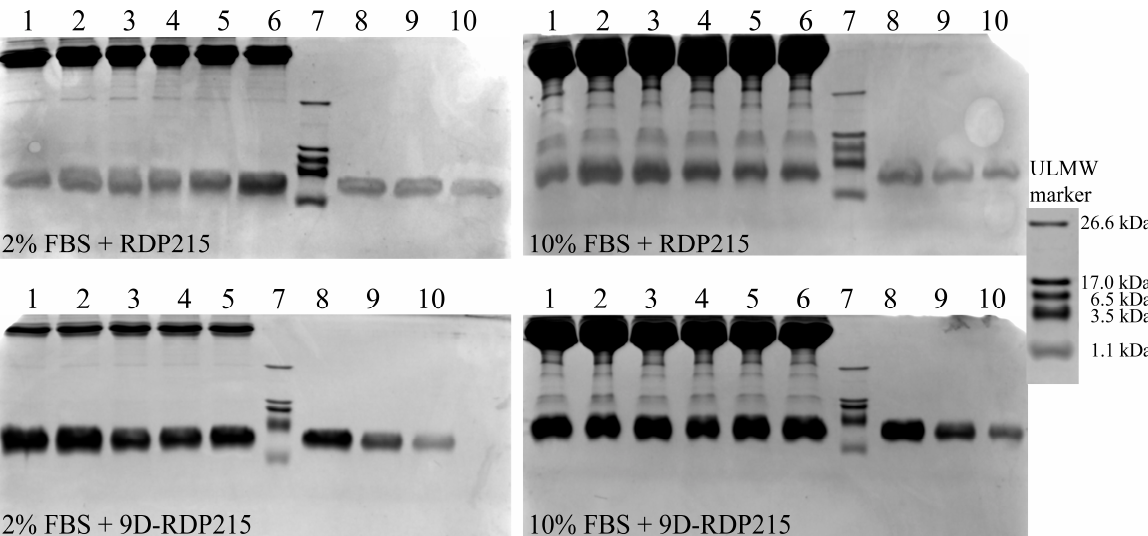
Figure 7. SDS-polyacrylamide gel electrophoresis of stability studies of RDP215 ( top ) and 9D-RDP215 ( bottom ) in the presence of 2% and 10% fetal bovine serum (FBS). Peptides (2.5 µg per sample) were incubated at 37 °C for up to 7 days in the presence of 2% and 10% FBS, respectively. Two percent FBS ( left ) and 10% FBS ( right ): Lane 1–6: 2.5 µg of the respective peptide was incubated in presence of 2% FBS or 10% FBS for 0 h (lane 1), 1 h (lane 2), 8 h (lane 3), 24 h (lane 4), 2 days (lane 5) and 7 days (lane 6). Molecular weights can be estimated from the ULMW marker (lane 7), and fragment sizes are given on the right. Lane 8–10: 2.5 µg, 1 µg and 0.5 µg of the respective peptide control. Bottom left (2% FBS+9D-RDP215), no lane 6 (7 days). Presented data are representative of the results of at least two independent measurements. Neither RDP215 nor 9D-RDP215 show any sign of peptide degradation upon incubation with 2% or 10% FBS.